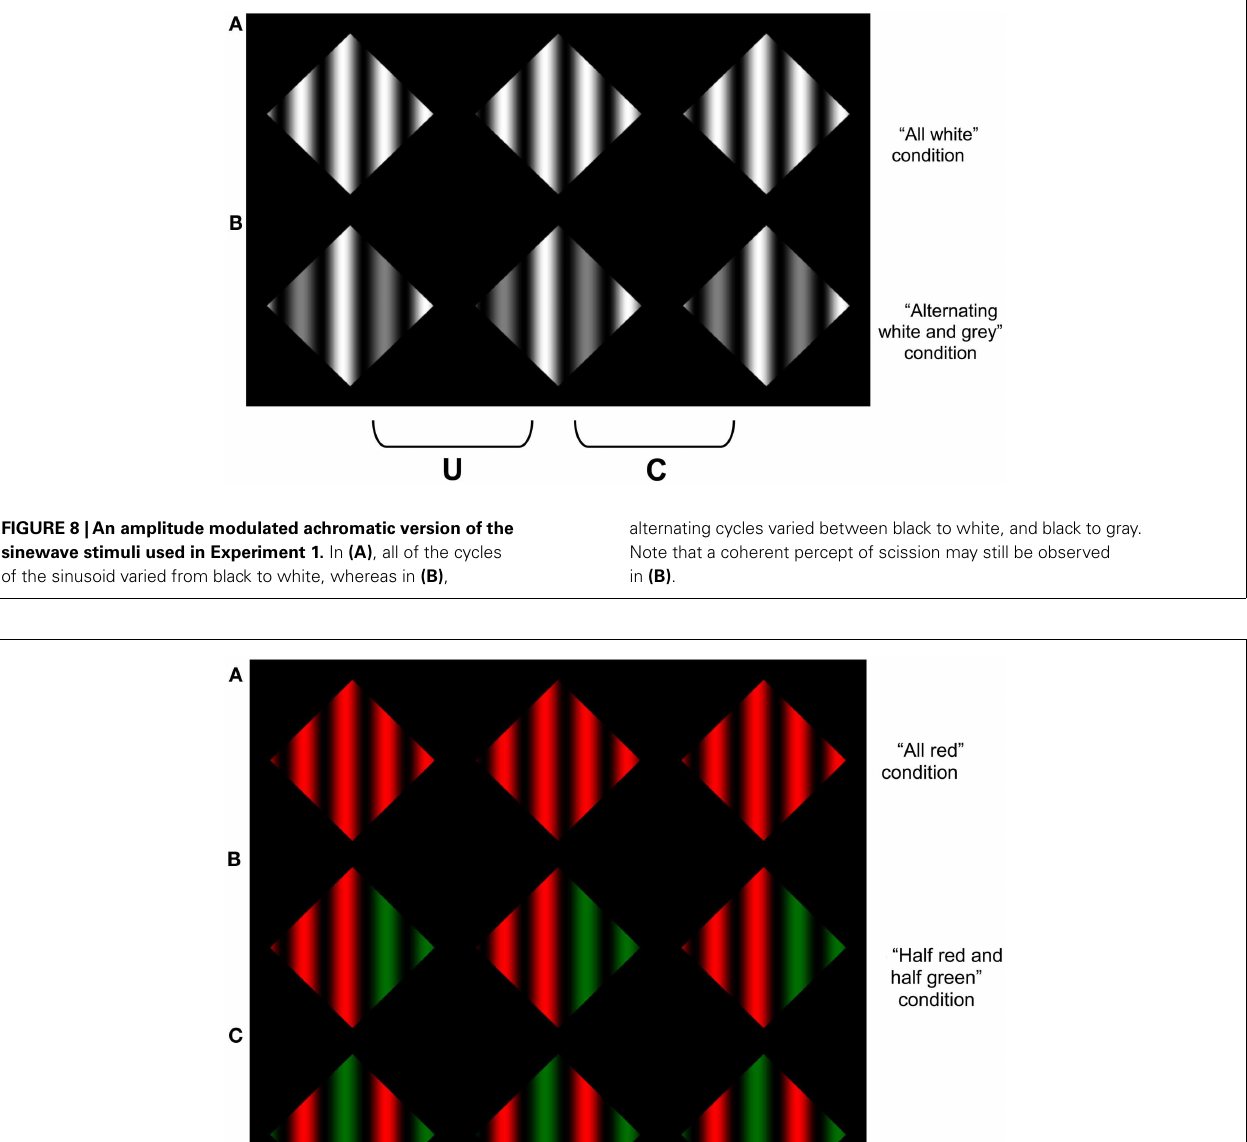
left columns are divergently fused, or the two right columns cross fused, coherent scission may be experienced in both (A,B) , but less so in (C)